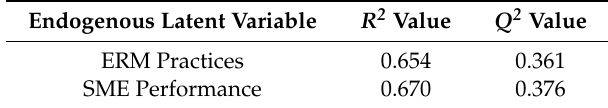
Table 7. Results of coe ffi cient of determination ( R 2 ) and predictive relevance ( Q 2